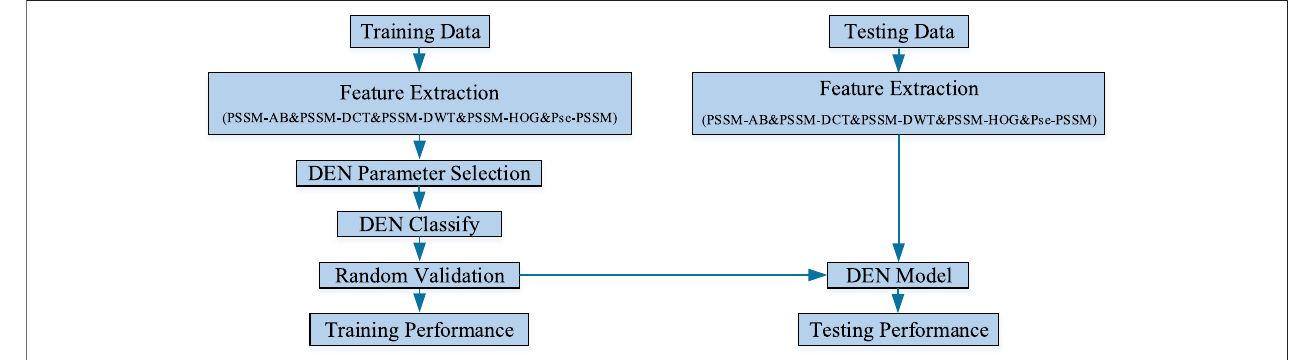
FIGURE 2 | The research infrastructure for this approach.